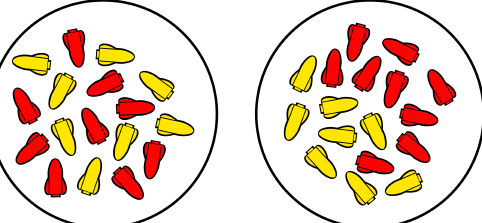
Figure 5. The collective memory is encoded in the spatial structure, that is, the configuration adopted by the group of robots. To this end, the robots are divided in two teams that differ only by their color, red or yellow. On the left, the robots are aggregated in a mixed state, in which on average each robot has the same number of red and yellow neighbors. On the right, the robots are in a segregated state and they each have on average a majority of neighbors with the same color as